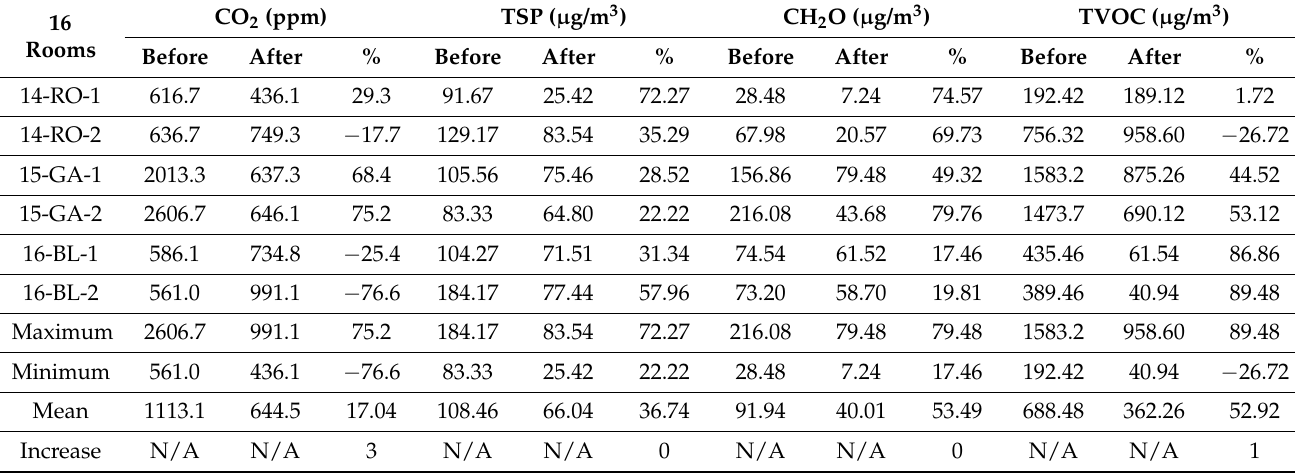
Table 6. Changes in Indoor Air Pollutants before and after Improvement with New Ventilation